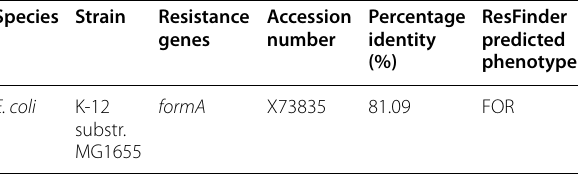
Table 6 ResFinder results for resistance genes of Escherichia coli